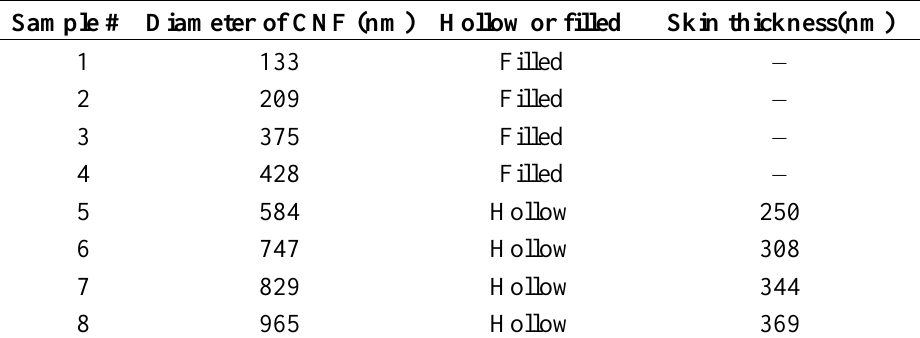
Table 1. Diameters of electrospun CNFs and their skins (samples subjected to accelerated stabilization at 294